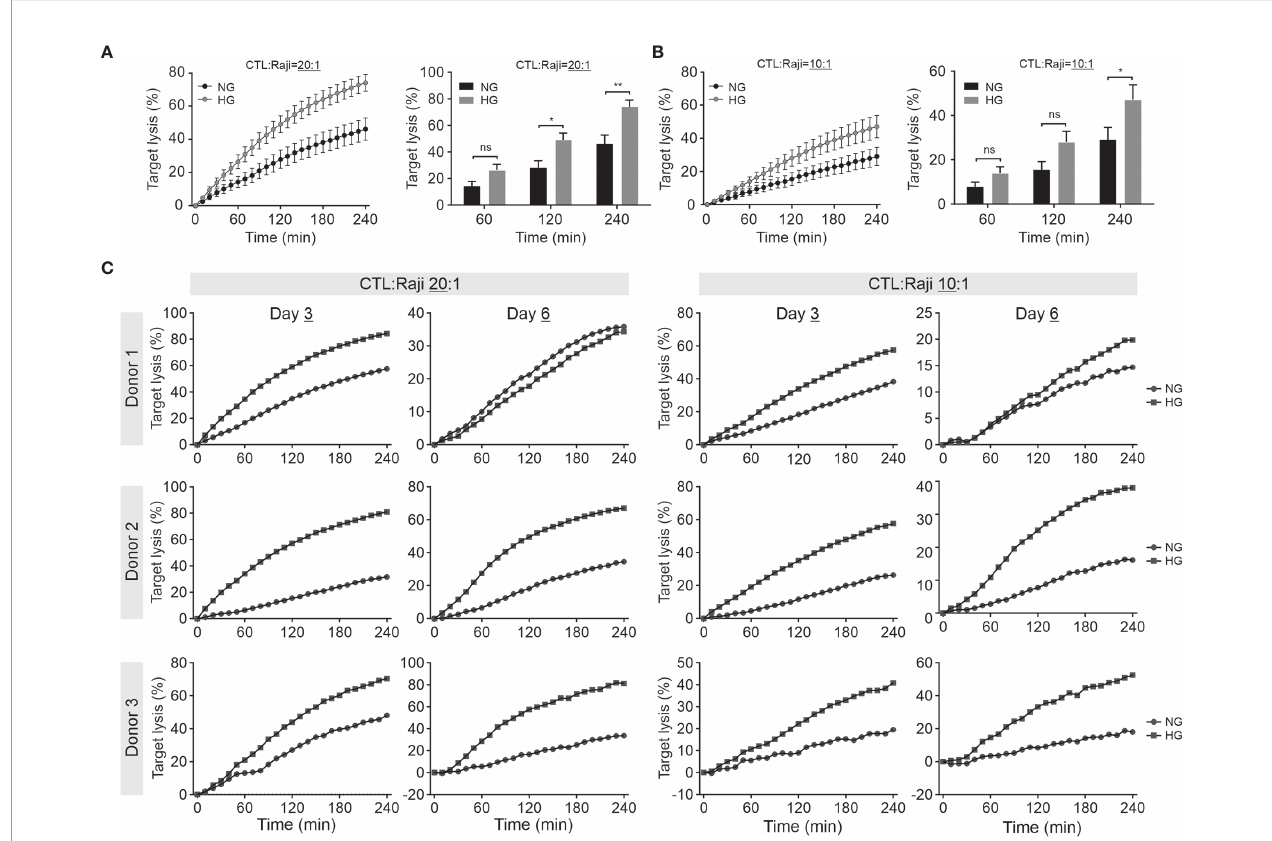
FIGURE 2 | Culture in HG enhances CTL-mediated cytotoxicity. Primary human CD8+ T cells were stimulated with anti-CD3/CD28-antibody coated beads in medium containing NG (5.6 mM) or HG (25 mM) for 3 days (A-C) or 6 days (C) as indicated. Killing kinetics was determined with the real-time killing assay. SEA/SEA pulsed Raji cells were used as target cells at an effector to target (E:T) ratio of 20:1 or 10:1. Results are from fi ve (A, B) or three donors (C) . * p < 0.05; ** p < 0.01; ns, not signi fi